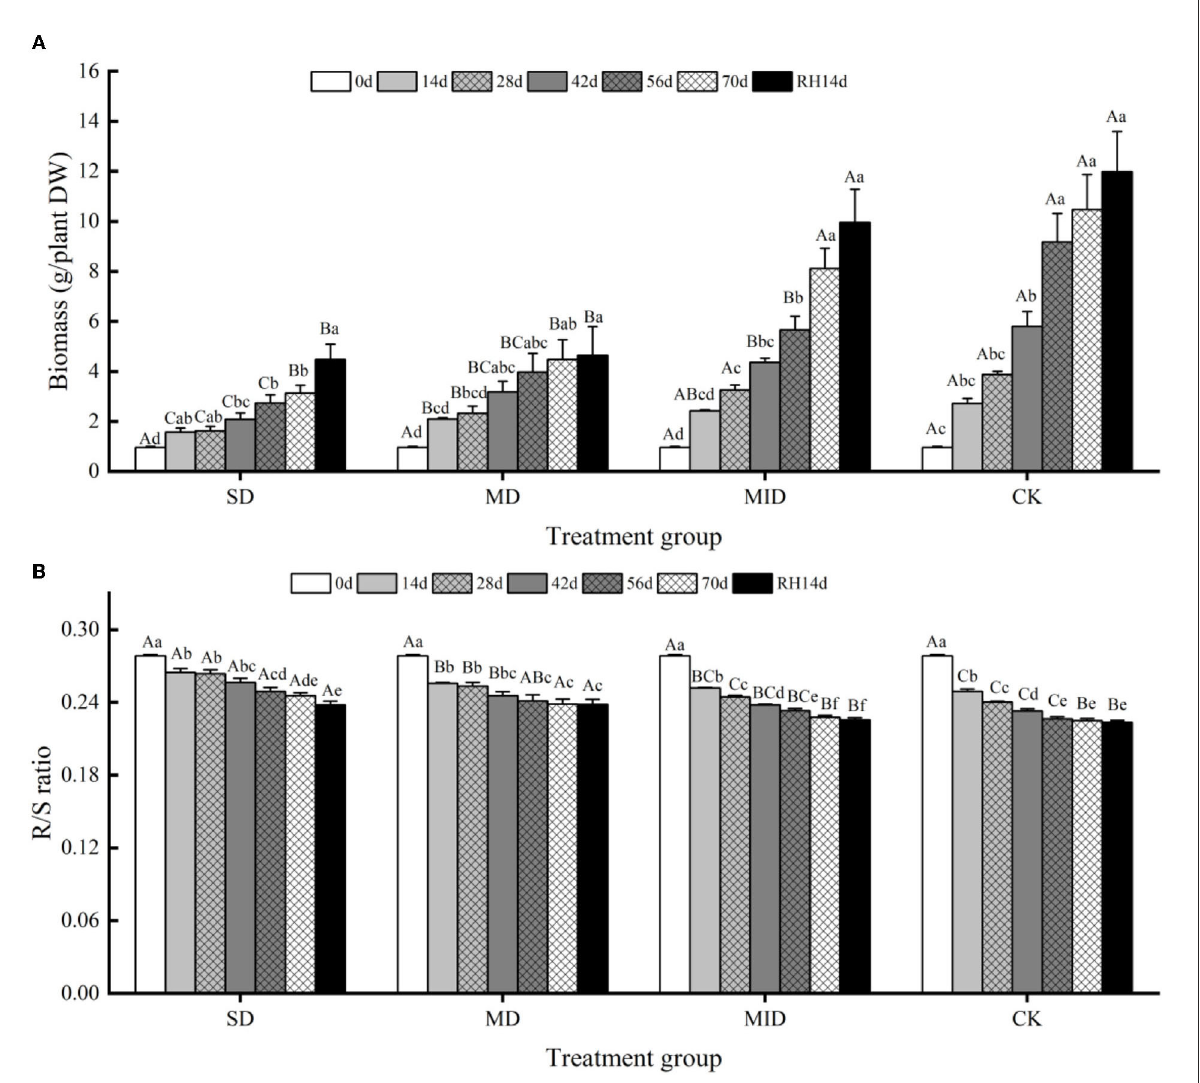
FIGURE5 The biomass and R/S ratio during the drought and rehydration for A. selengensis . 0 day, 14 days, 28 days, 42 days, 56 days, 70 days, and RH, 14 days, respectively, represent 0th, 14th, 28th, 42nd, 56th, 70th under drought and 14th day of rehydration. The severe drought group (SD), the moderate drought group (MD), the mild drought group (MID), the control group (CK). (A) Total biomass of A. selengensis . (B) The R/S ratio of A. selengensis . Different capital letters stand for significant differences between different drought groups ( p < 0.05), and different lowercase letters stand for significant differences between different experimental times ( p <